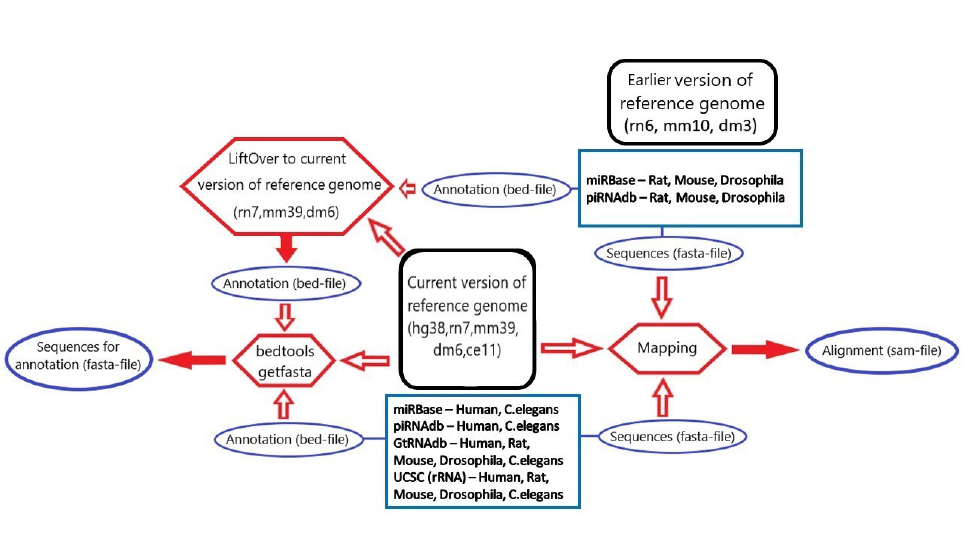
Figure 6. An overview of all steps for processing considered databases of small RNAs for 5